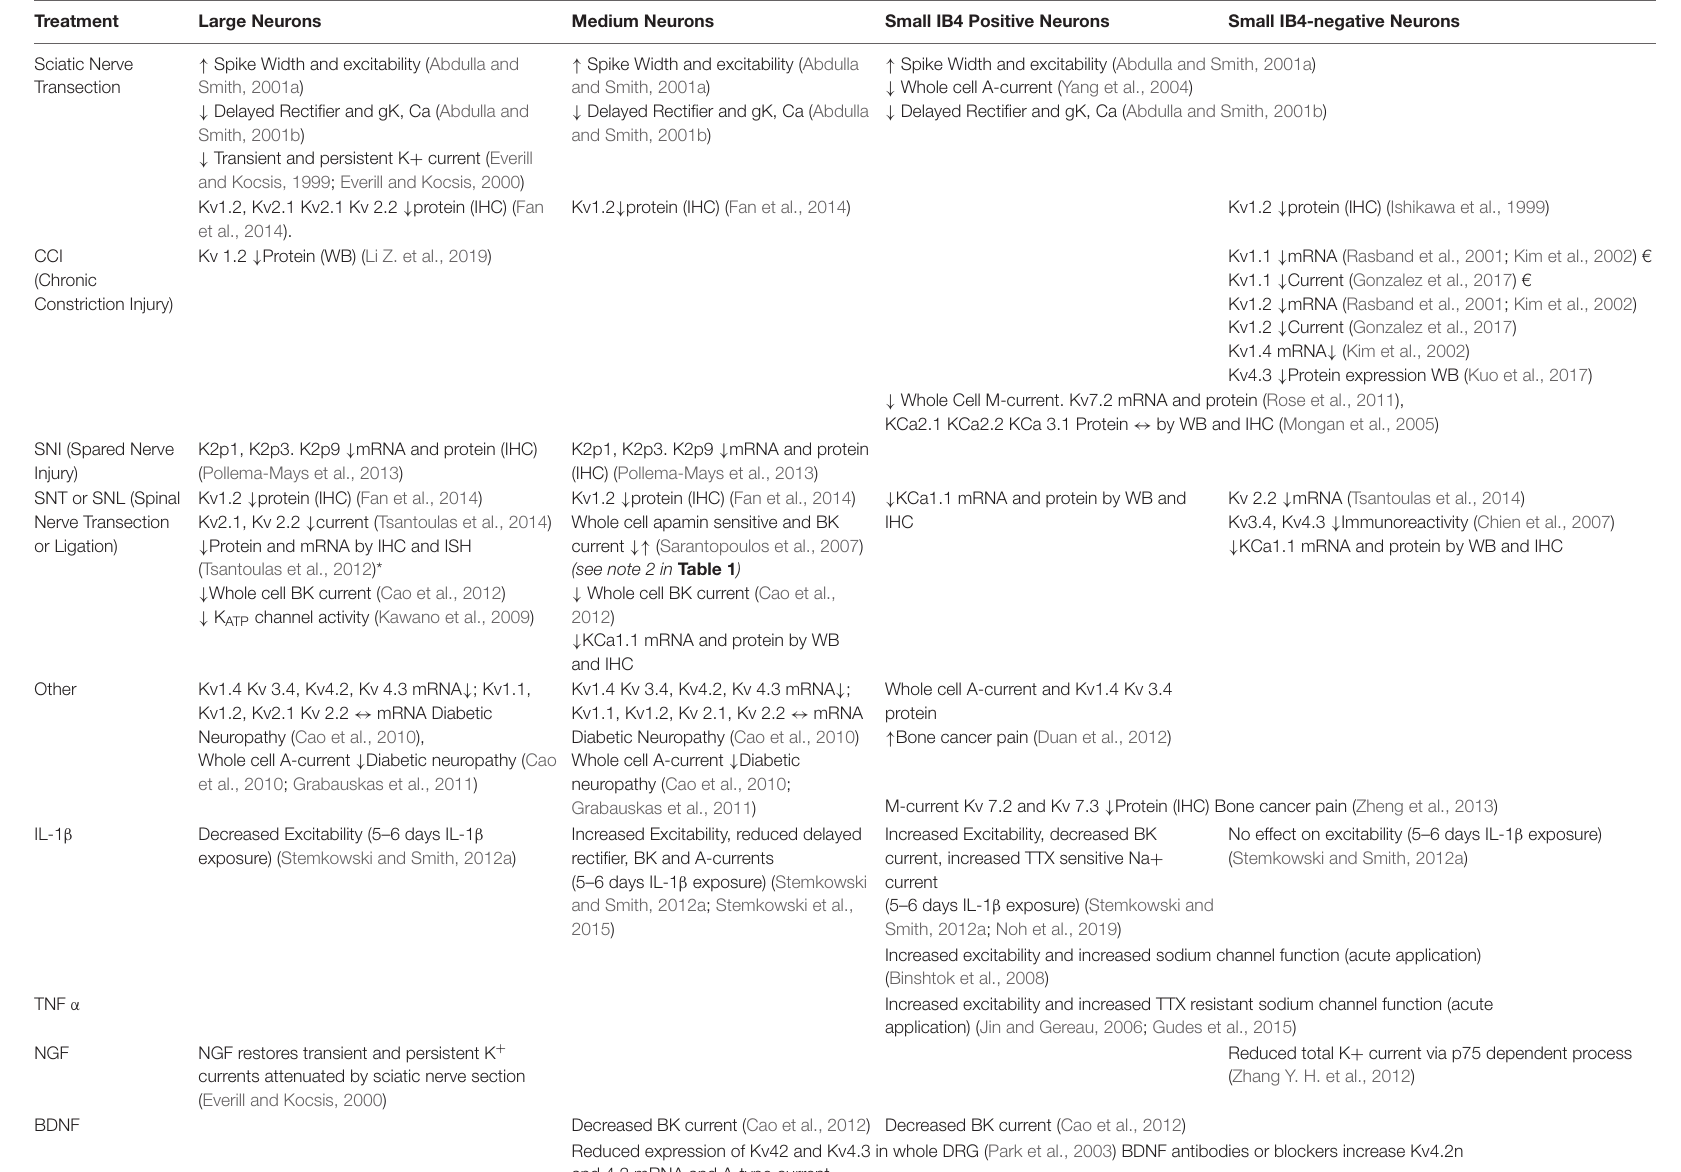
TABLE 2 | Effects of injury and inflammatory mediators on K + channel function in Large, Medium, Small IB4 positive and Small IB4 negative neurons. Treatment Large Neurons Medium Neurons Small IB4 Positive Neurons Small IB4-negative